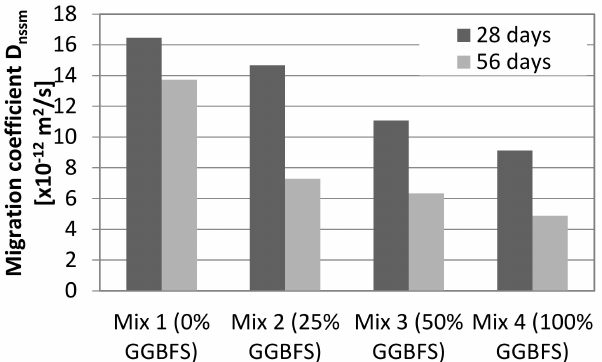
Figure 13. Rapid chloride migration coe ffi cient, D RCM , for mixes cured at 20ºC with di ff erent additions of